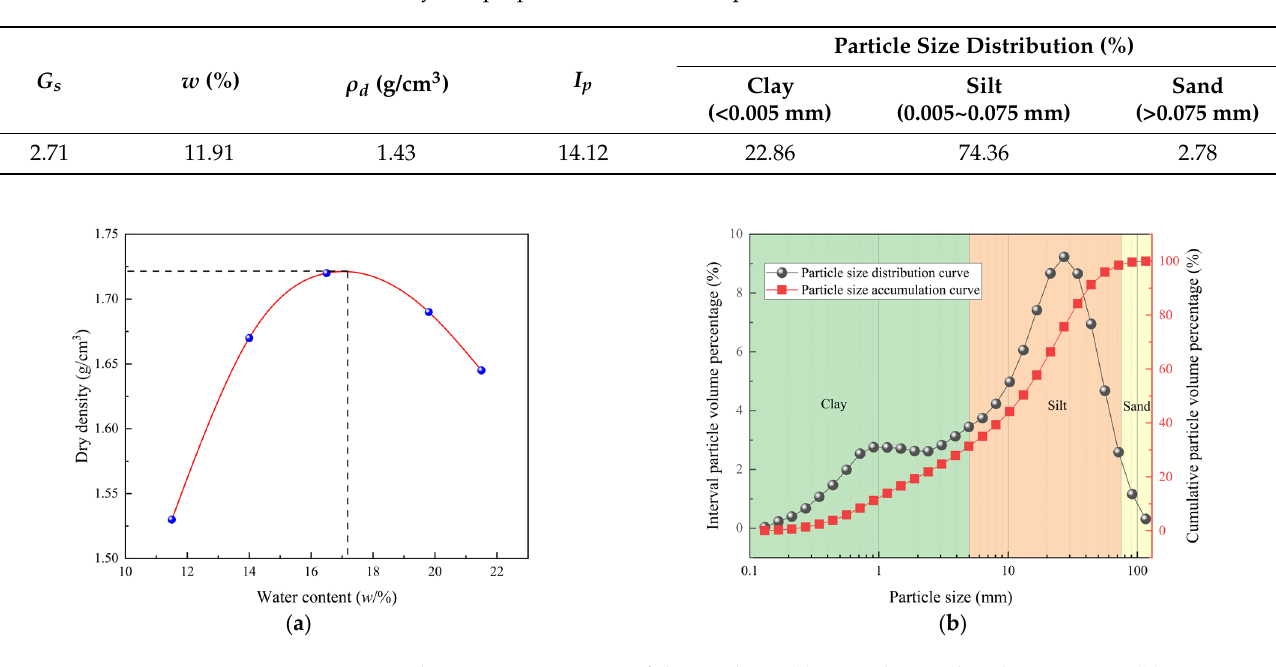
Figure 1. The compaction curve of the test loess ( a ), particle size distribution curve ( b ).